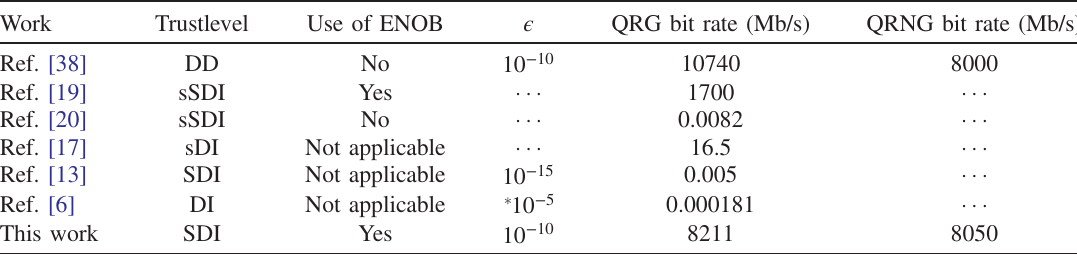
TABLE II. Comparison of randomness generation protocols. DD, device-dependent; sSDI, semi-source-device- independent; sDI, semi-device-independent; SDI, source-device-independent; DI, device-independent. The asterisk denotes “ not proven secure under composition of devices. ”